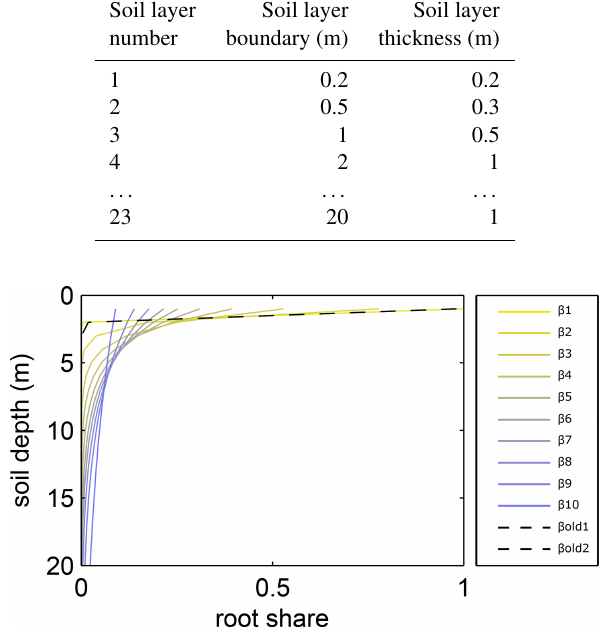
Figure A1. Relative amount of fine roots in each soil layer for dif- ferent β values in LPJmL4.0 and LPJmL4.0-VR. In the legend, β old1 and β old2 correspond to the β values of the two tropical tree PFTs (deciduous and evergreen) simulated in LPJmL4.0. The corresponding graphs lie on top of each other due to marginal differ- ences in their β values. β 1– β 10 correspond to the 10 β values used in LPJmL4.0-VR (Table A2) to create the 10 sub-PFTs of the trop- ical evergreen and deciduous tree PFTs (Appendix A, Sect. A1.3). For LPJmL4.0-VR the fine-root distribution at maximum rooting depth is shown. Please note, the first three soil layers (as described in Appendix A, Sect. A1.1) in this visualization are treated as one layer of 1m thickness for reasons of visual